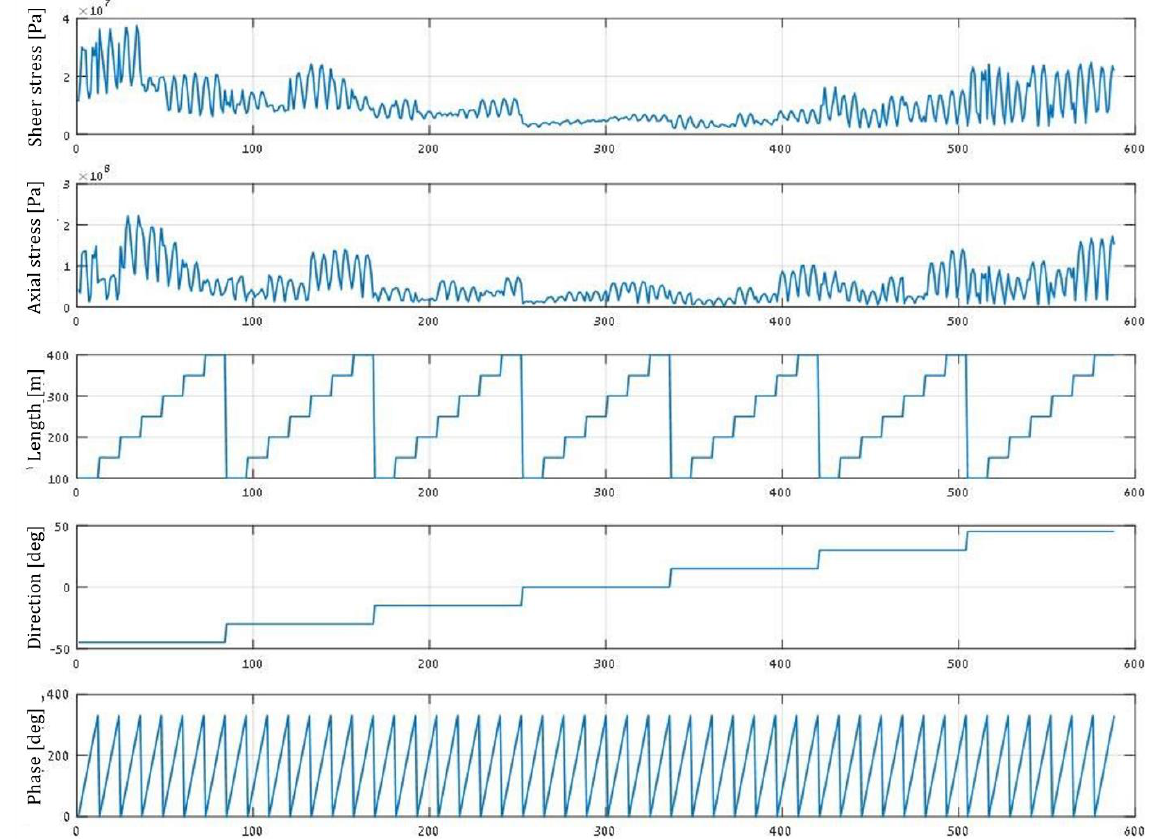
Figure 10. Illustration of the interactive plot (procedure output)- Shear and axial stresses using the simplified analytical model for hull girder primary strength. From top to bottom: shear stress (results), axial stress (results), wavelength (input), wave direction (input), and wave phase (input). The x axis presents the serial number of the load case (wave combinations). As can be observed, the potentially critical load cases are readily identified as the two peak axial stress value of the 200 m’ −45° wave (on the left side of the axial stress plot). Note that the interactive property of this plot could not be presented here.